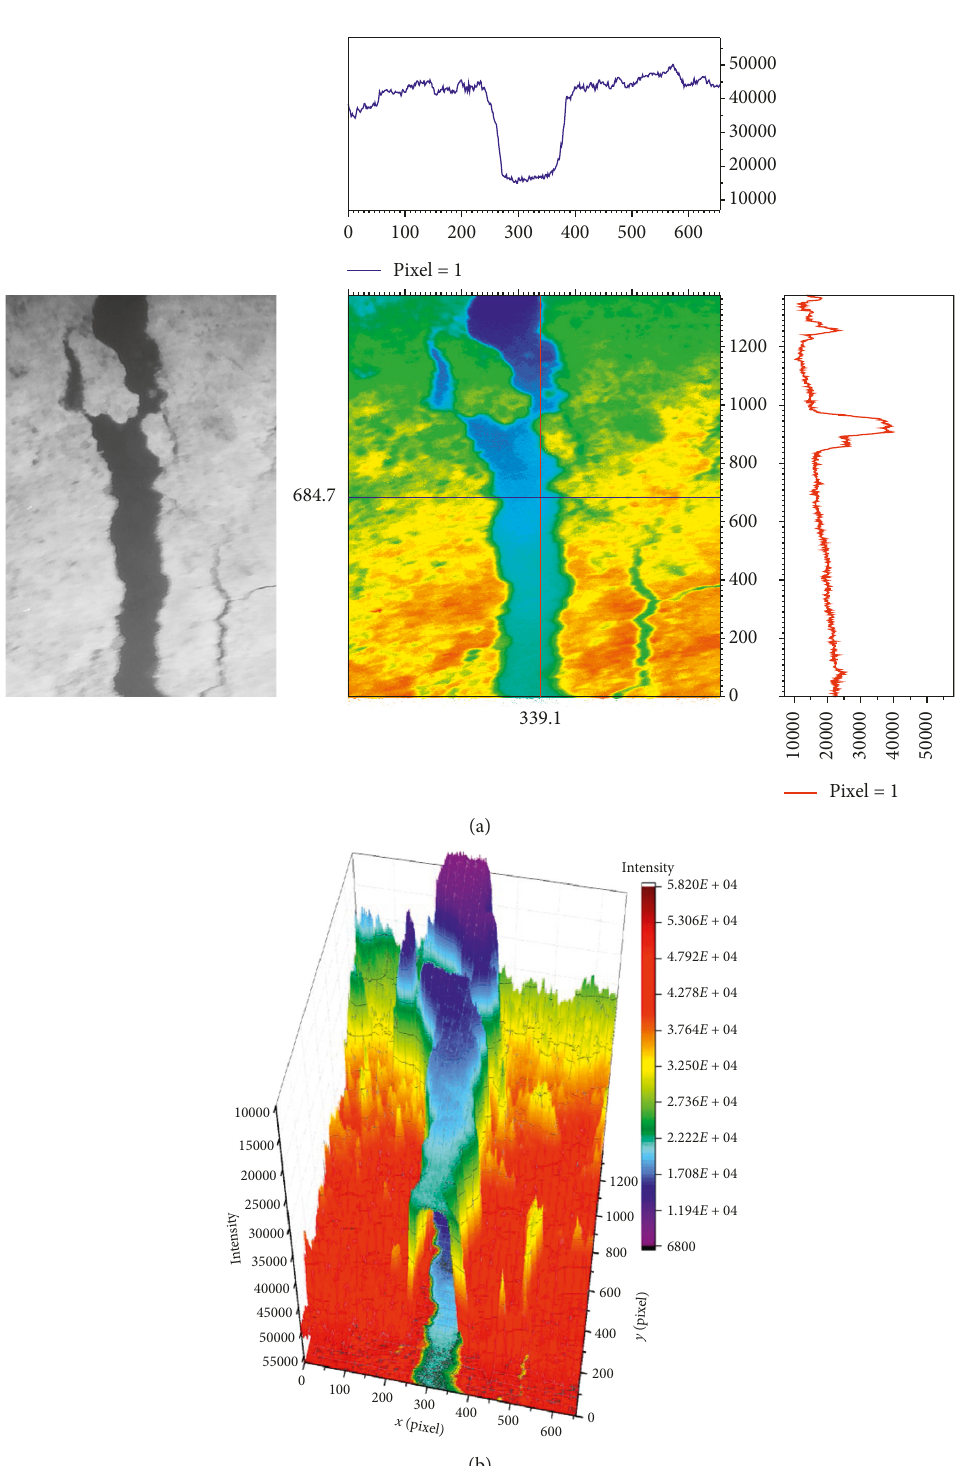
Figure 9: Gray scale image of a crack with displaced parts, profiles of reflected light intensity, and 3D graph of crack with the axis of the intensity Figure 4. Two cracks specified with number 1 and 2 are shown. The 2D and 3D form presentations of the distribution still reveal the nonuniform intensity difference though the crack area appears as only darker than its surrounding wall. The